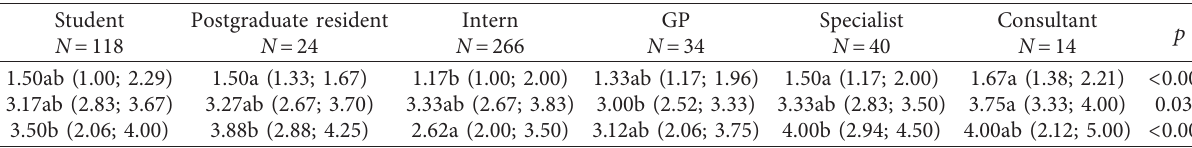
Table 7: Comparison of the knowledge and use of caries detection and caries risk assessment methods across levels of